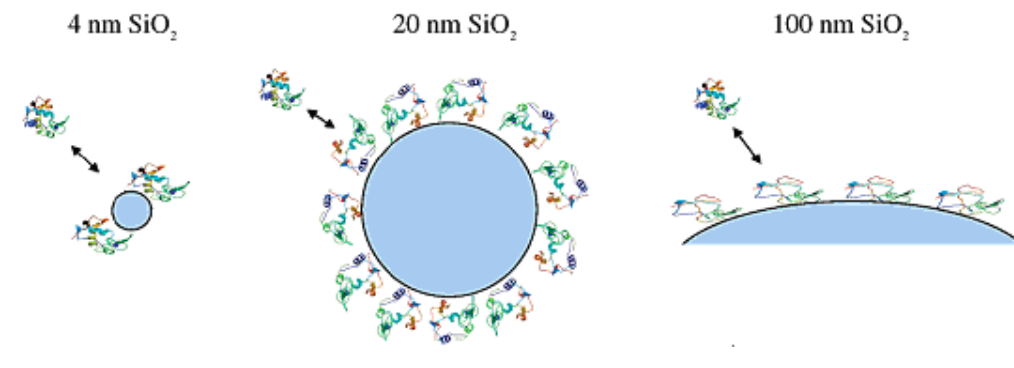
Figure 4. Schematic of lysozyme adsorption on silica particles with different sizes. Stronger protein particle interactions exist in the case of larger nanoparticles, resulting in more protein unfolding and less enzymatic activity (reproduced with permission from [27] © 2004, American Chemical